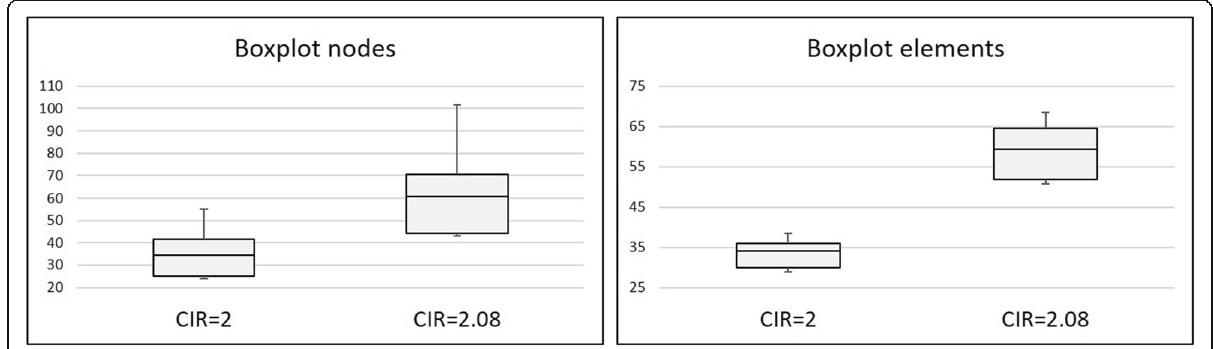
Fig. 11 Boxplots showing the significant differences shown by the comparison between the stresses computed in the CIR = 2 model and the CIR = 2.08